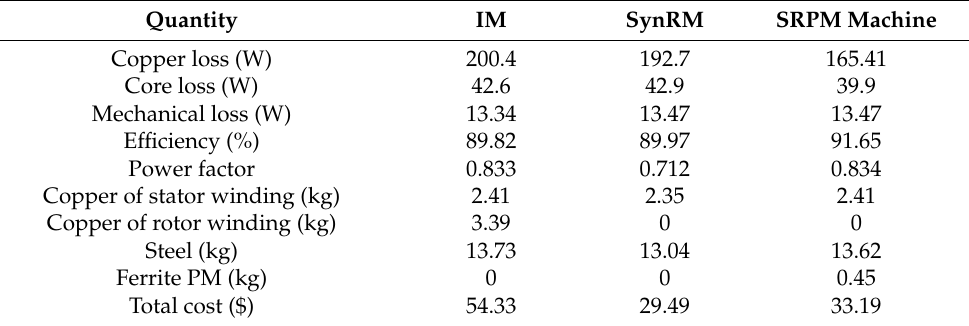
Table 1. Comparison between IM, SynRM and SRPM machines